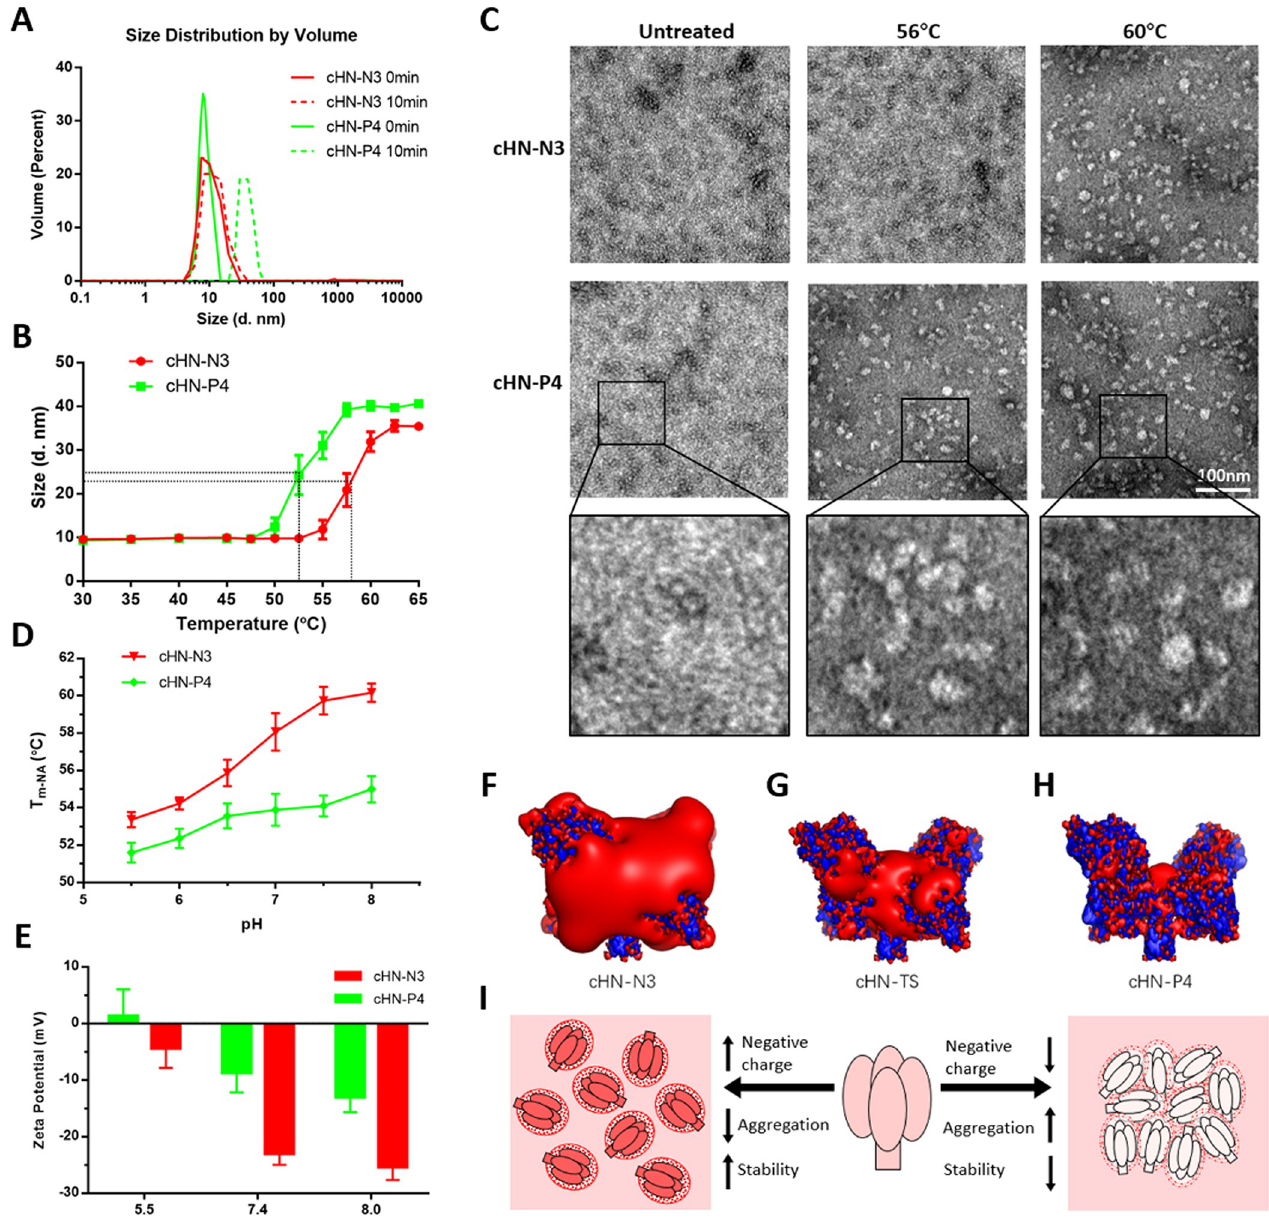
Fig 5. Effect of the surface charge of HN protein on its temperature-induced aggregation. (A) The DLS spectra of HN proteins heat-treated for 10 min at 56˚C are measured using Zetasizer Nano ZS (Malvern). (B) Temperature-induced aggregation of cHN as monitored by protein size. After heat-treatment at the indicated temperature for 10 min, the proteins are tested for size. The protein stability is shown as the temperature for a 50% increase in the size of protein heat-treated for 10 min (T m-SZ ). (C) Electron micrographs of heat-treated HN proteins. cHNs are heat-treated at the indicated temperature for 10 min, then negatively stained with uranyl formate. (D) Effect of pH on the stability of cHN proteins. T m-NA of protein at the indicated pH is shown as the temperature for a 50% decrease in NA activity of protein heat-treated for 10 min. (E) Zeta potentials of HN proteins at the indicated pH are measured using Zetasizer Nano S (Malvern). (F-H) Negative and positive iso-potential contours of HN proteins are displayed at a level of -5 kT/e (red) and +5 kT/e (blue), respectively. The names of HN proteins are indicated at the bottom of structures. The structures of HN proteins are obtained by homology modeling, using the HN structure of AV strain (PBD ID code 3T1E) as a template. (I) Proposed model for the effect of surface charge of HN protein on its temperature-induced aggregation.